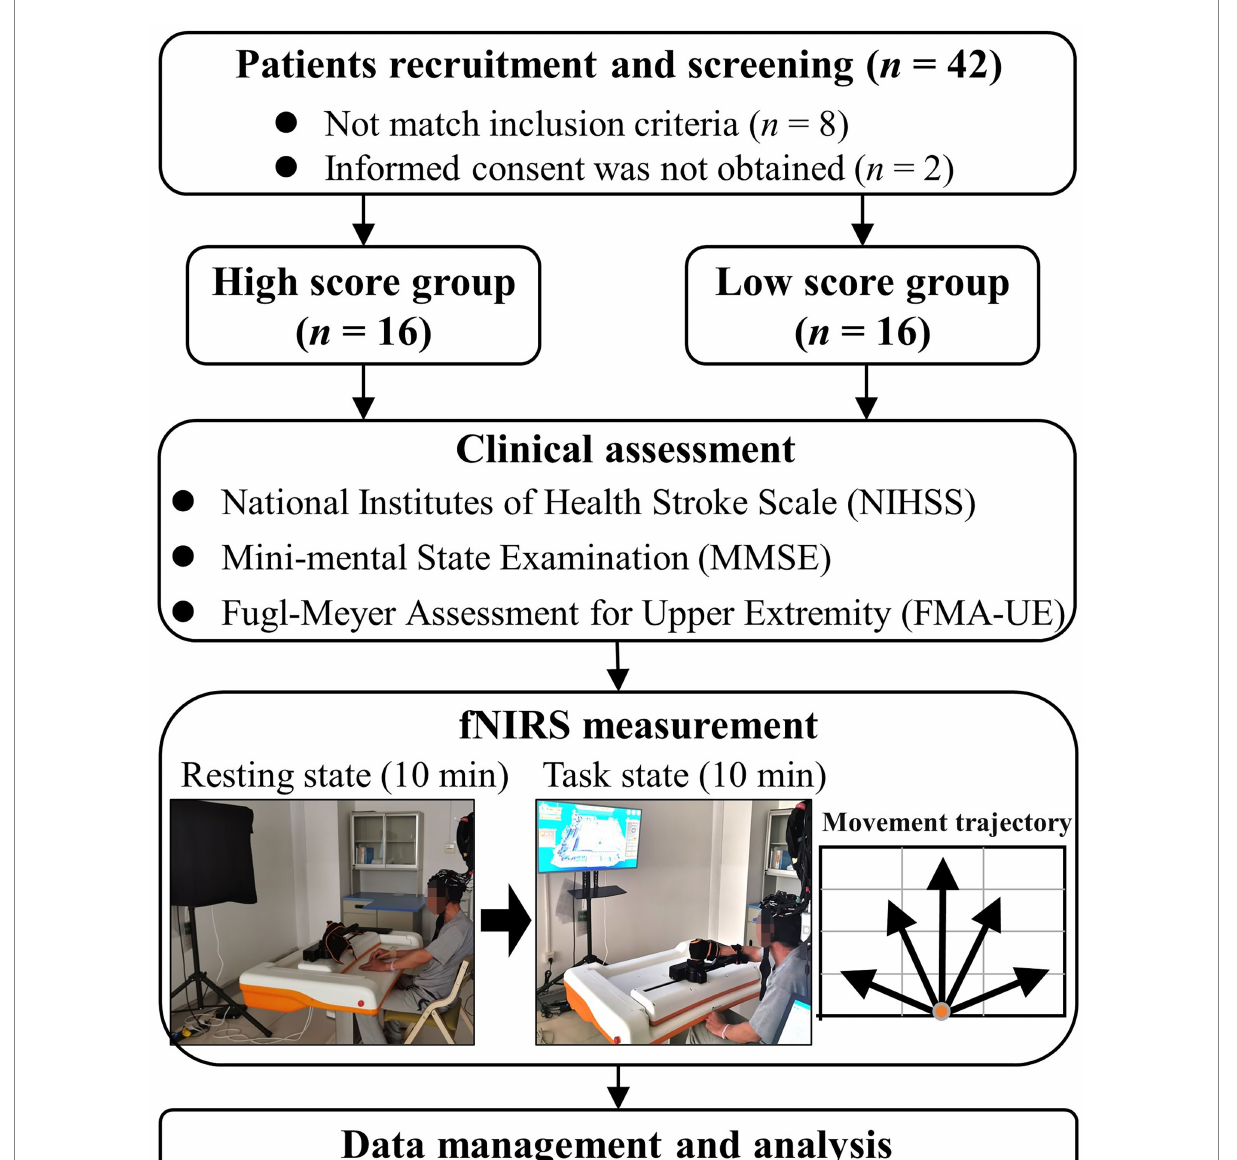
FIGURE 1 Flow-chart through this